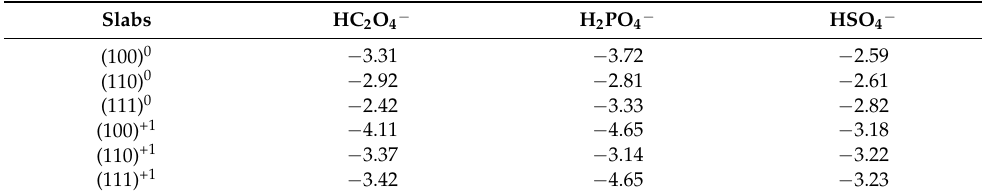
Table 2. The E rep (eV) values of acid radicals replacing H 2 O.